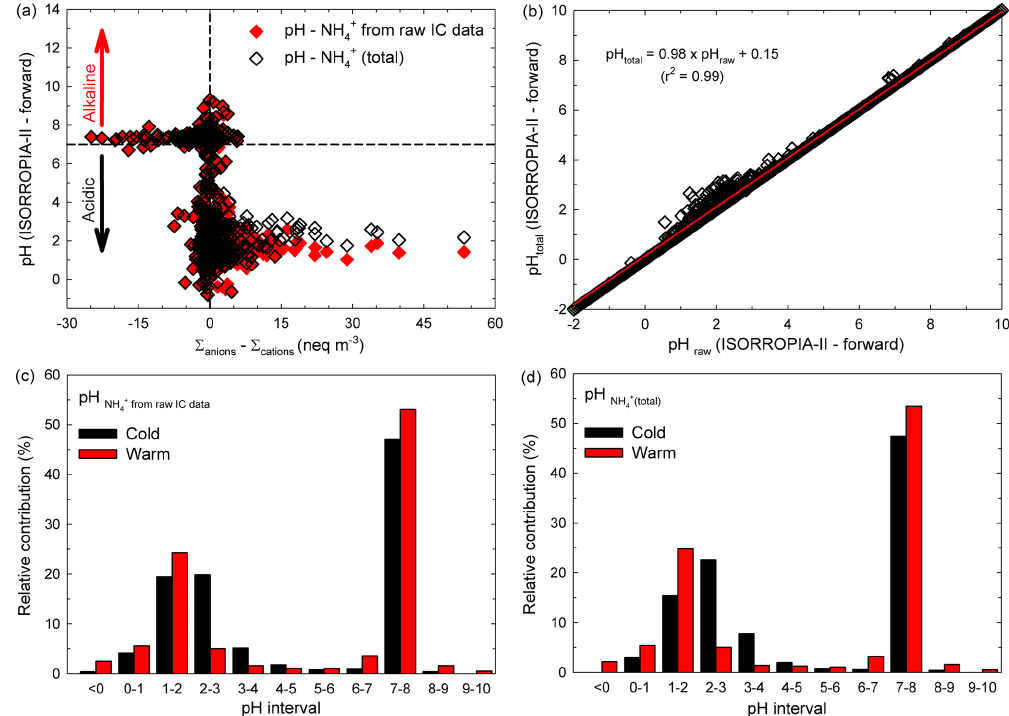
Figure 4. Distribution of the aerosol pH predicted by ISORROPIA-II (forward mode) vs. the ion balance (a) , sensitivity of aerosol pH predicted with the model to small changes in the input aerosol NH + concentration (b) , and bar chart distribution in aerosol pH over the warm 4 and cold seasons for both NH + derived from raw IC data (c) and NH + (total) (d) 4 4